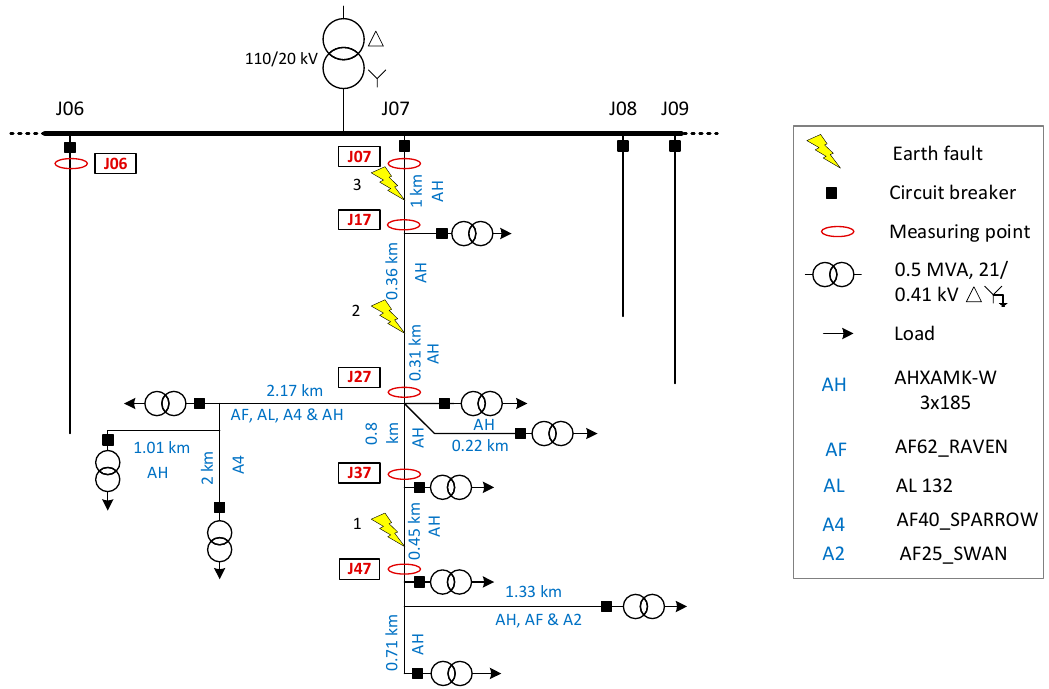
Figure 4. Medium voltage network with isolated neutral under three fault location scenarios with various measuring points along the feeder.